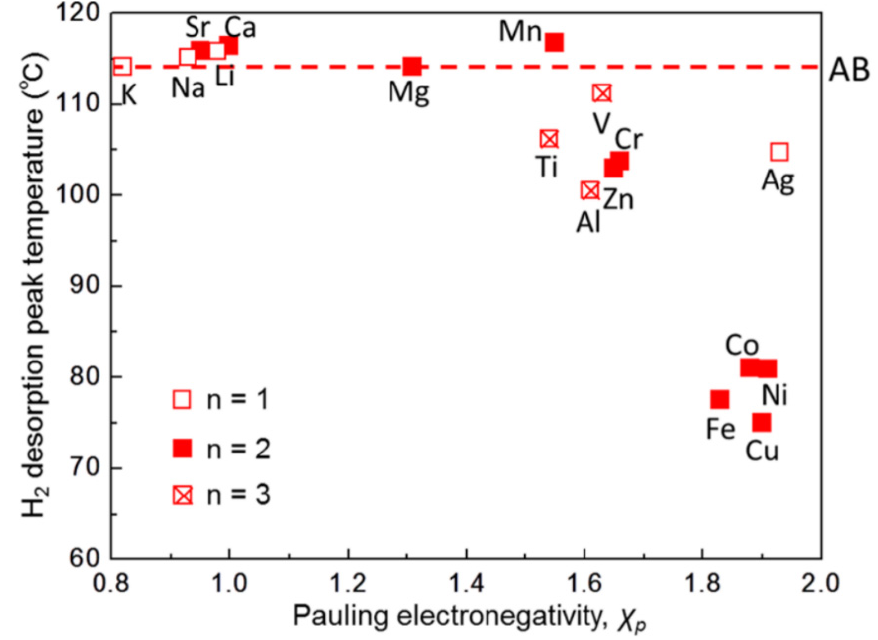
Figure 14. H 2 desorption peak temperatures of AB/MCl x mixtures. Reprinted with permission from [240]. Copyright (2016), American Chemical Society.